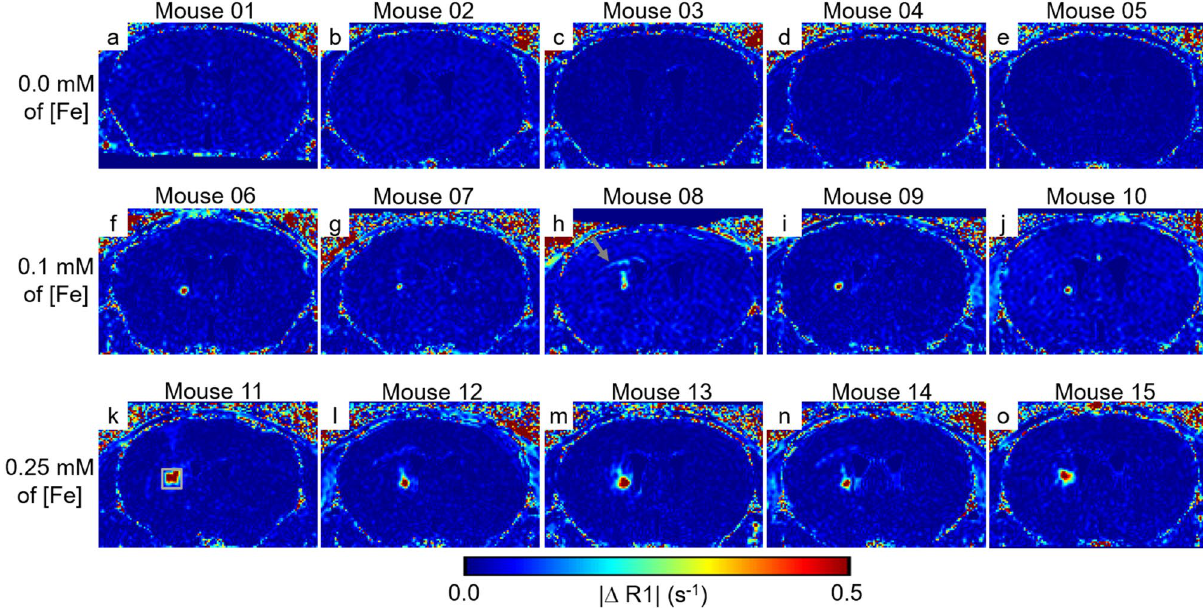
Figure 7. Consistent detection of ESIONPs after injection. All maps were zero-filled from 160 × 160 × 160 µm 3 to 80 × 80 × 80 µm 3 . Each panel represents for individual mouse, total 15 mice. ( a – e ) | ΔR1| maps after injection of 1 µl of saline in 5 individual mice. ( f – j ) | ΔR1| maps after injection of 1 µl of ESIONPs at 0.1 mM iron concentration in 5 additional mice. ( k – o ) | ΔR1| maps after injection of 1 µl of ESIONPs at 0.25 mM iron concentration in 5 additional mice. The box in panel ( k ) indicates the region of interest used for quantitative analysis. Note that small amounts of signal change ipsilateral to injection indicated by arrow can be detected, likely due to variability in injection technique.